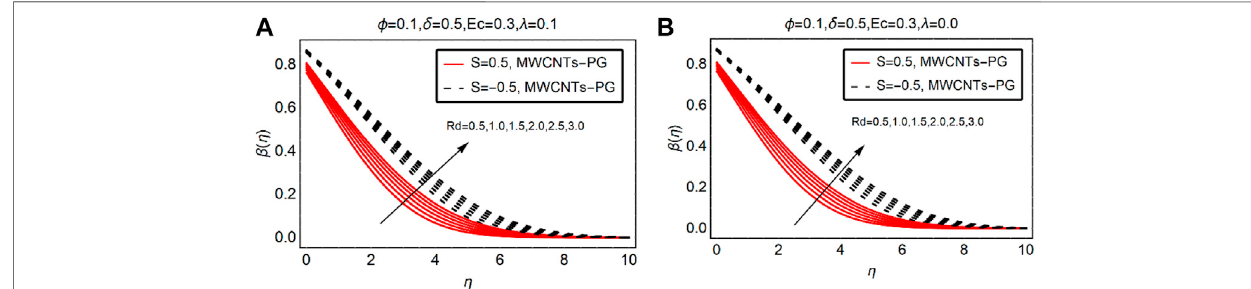
FIGURE 7 | β ( η ) against Rd (A) λ > 0 and (B) λ (cid:2) 0.